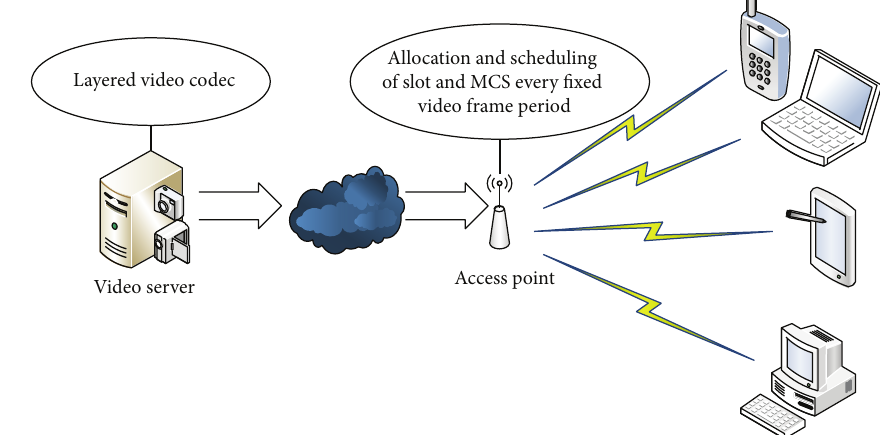
Figure 2: System architecture for scalable video